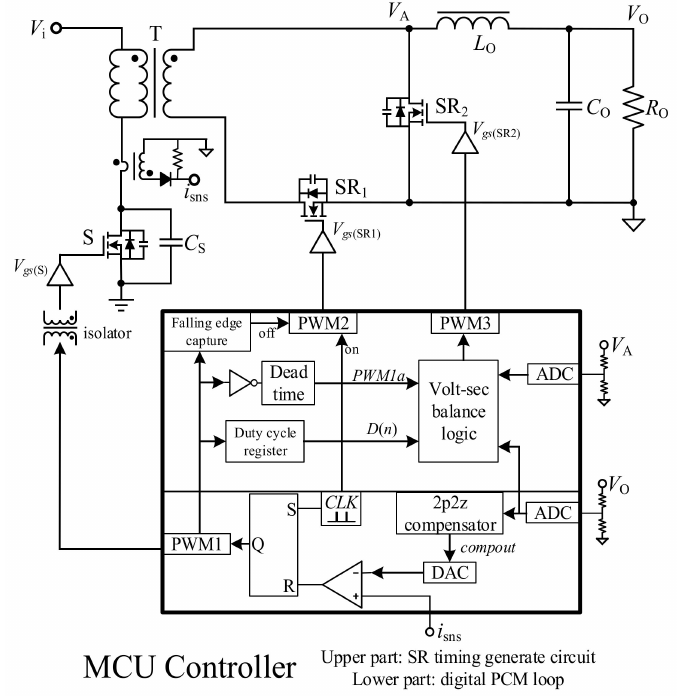
Figure 4. The proposed control diagram in